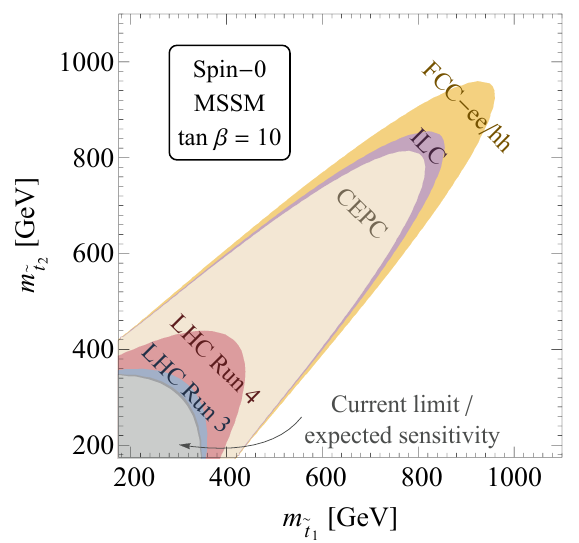
Figure 7 . Excluded parameter space and projected expected sensitivities at the 2 (cid:27) C.L. of current and future data, respectively, for stops in the MSSM in the m ~ space formally excluded by current LHC and Tevatron data is shown in dark gray. It mostly overlaps with the current expected sensitivity in light gray. Future LHC runs and the proposed future colliders (ILC, CEPC, and FCC-ee/hh) are shown in various